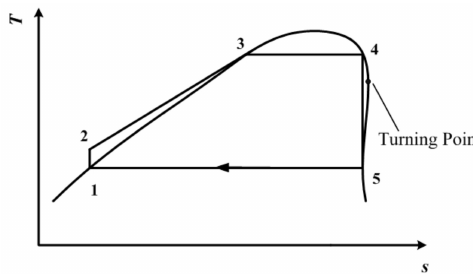
Figure 3. Subcritical ORC with a single-screw expander when the working conditions of the expander inlet are known.